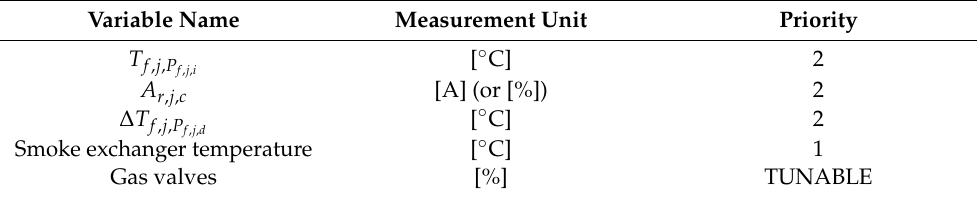
Table 6. APC main